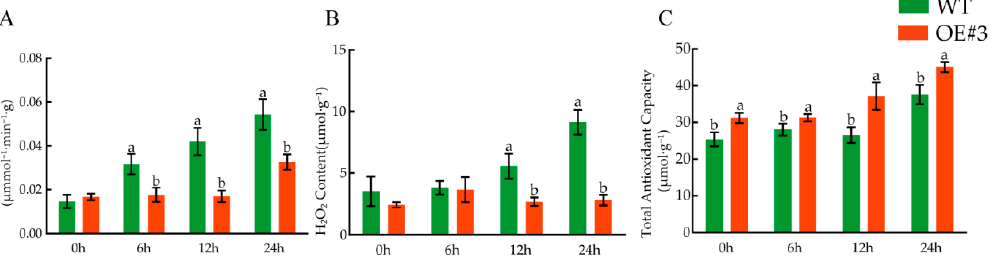
Figure 16. Determination of related physiological indices under low ‐ temperature treatment. ( A ) Su ‐ peroxide anion production rate. ( B ) H 2 O 2 content. ( C ) Total antioxidant capacity. Bars with different letters “a, b, c, d” above the columns indicate significant differences ( p < 0.05, Duncan’s range test) on a given day of treatment.